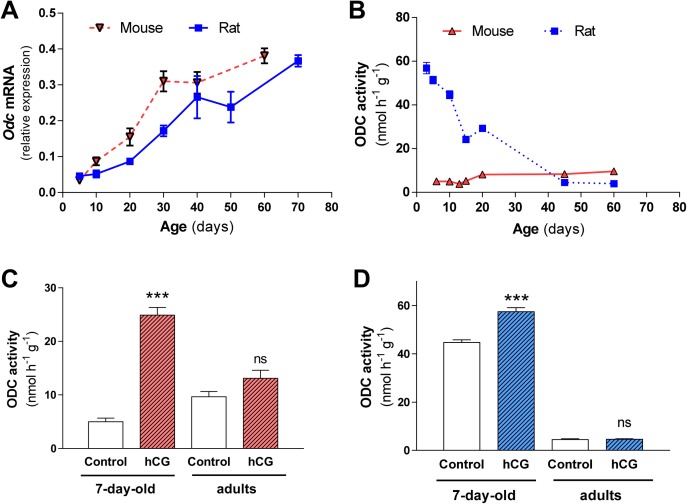
Comparative expression of ODC mRNA levels and ODC activity in testes of mice and rats during the postnatal period.Effect of treatment with human chorionic gonadotropin (hCG). A) RNA from a testis of CD1 mice and Sprague-Dawley rats at different ages was isolated and analyzed by real time RT-PCR. Expression values were normalized with respect to β-actin (Pearson correlation coefficient r = 0.9483, P = 0.0034 for mice; r = 0.9754, P = 0.0002 for rats). B) ODC activity was assayed in the contralateral testis of mice and rats at different ages (Pearson correlation coefficient r = 0.8727, P = 0.014 for mice; r = -0.9287, P = 0.0025 for rats). C) ODC activity in testes of young and adult mice after the treatment with hCG for 5h D) and rats (blue) ODC activity in testes of young and adult rats after the treatment with hGG for 5h. Results are expressed as mean ± SEM of 3 animals per group (A,B) or 5 animals per group (C,D). Statistical significance: *** P<0.001 vs its control group; ns, not significant.